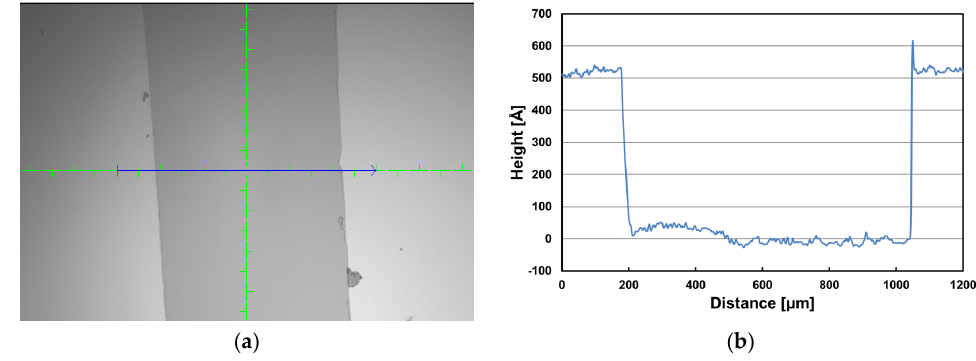
Figure 2. ( a ) A microscopy image of the chromium-coated silicon wafer. The dark area in the center was partially covered during the film deposition for the thickness measurement along the blue arrow; ( b ) thickness measurement data using a profilometer.